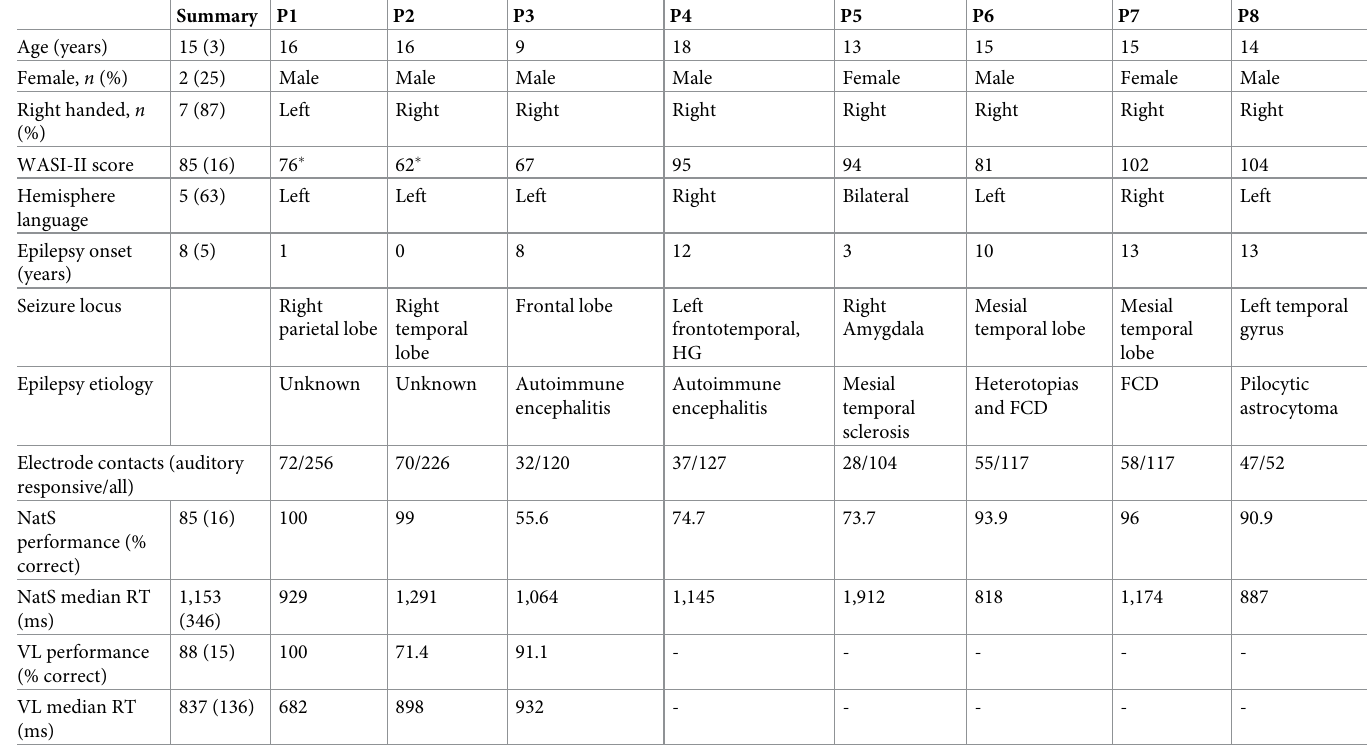
Table 1. Participant epilepsy and behavioral